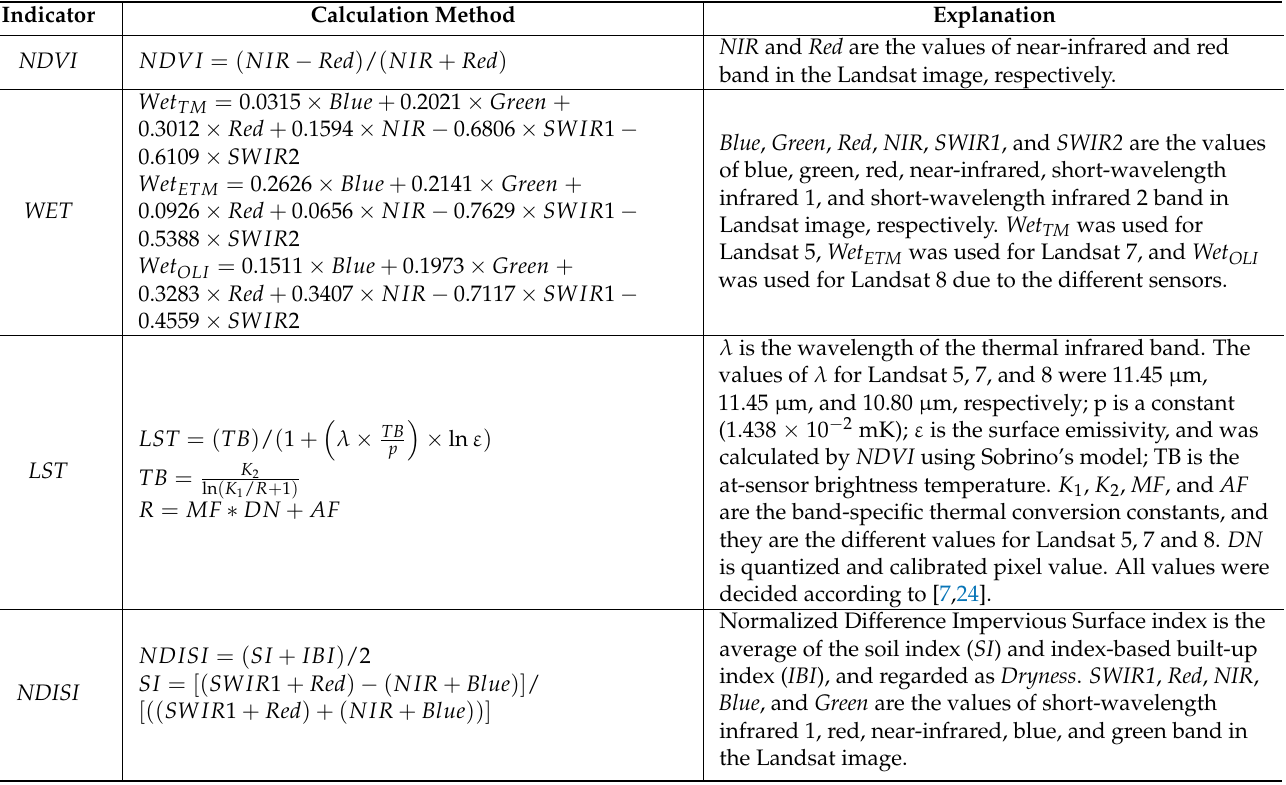
Table 1. The formulae and explanations of four metrics in